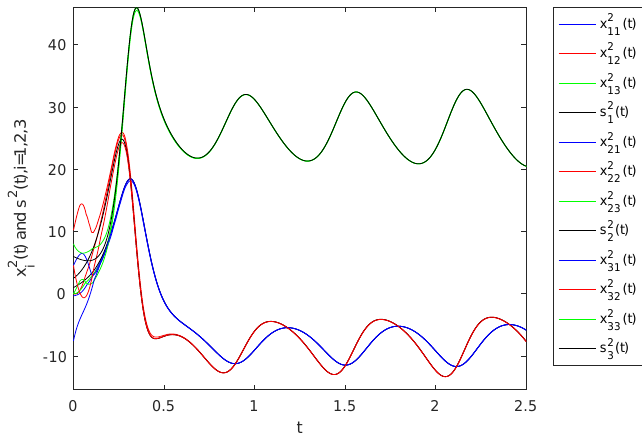
( 2 ) ( t ) and s ( 2 ) ( t ) under Controller (17). ı